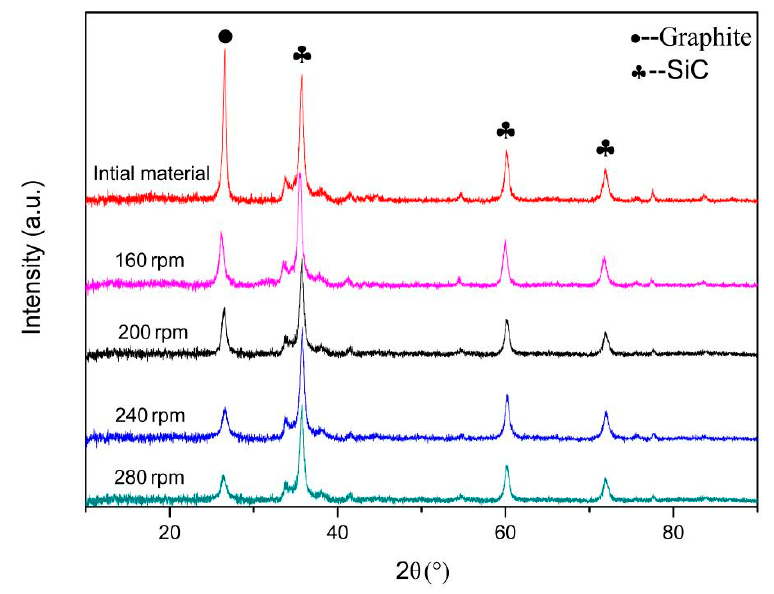
Figure 12. XRD patterns of the composites at different rotational speeds and initial materials.